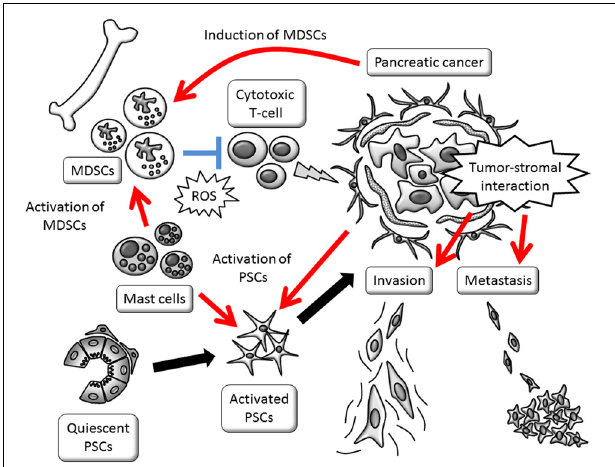
FIGURE 1 | Schematic view of tumor-stromal interactions affecting invasive growth and escape from immune surveillance. Promotion of invasive phenotype is mainly provided by activated PSCs. PSC activation and MDSC induction are stimulated by cancer cells. MDSCs, myeloid-derived suppressor cells; PSCs, pancreatic stellate cells; ROS, reactive oxygen species.